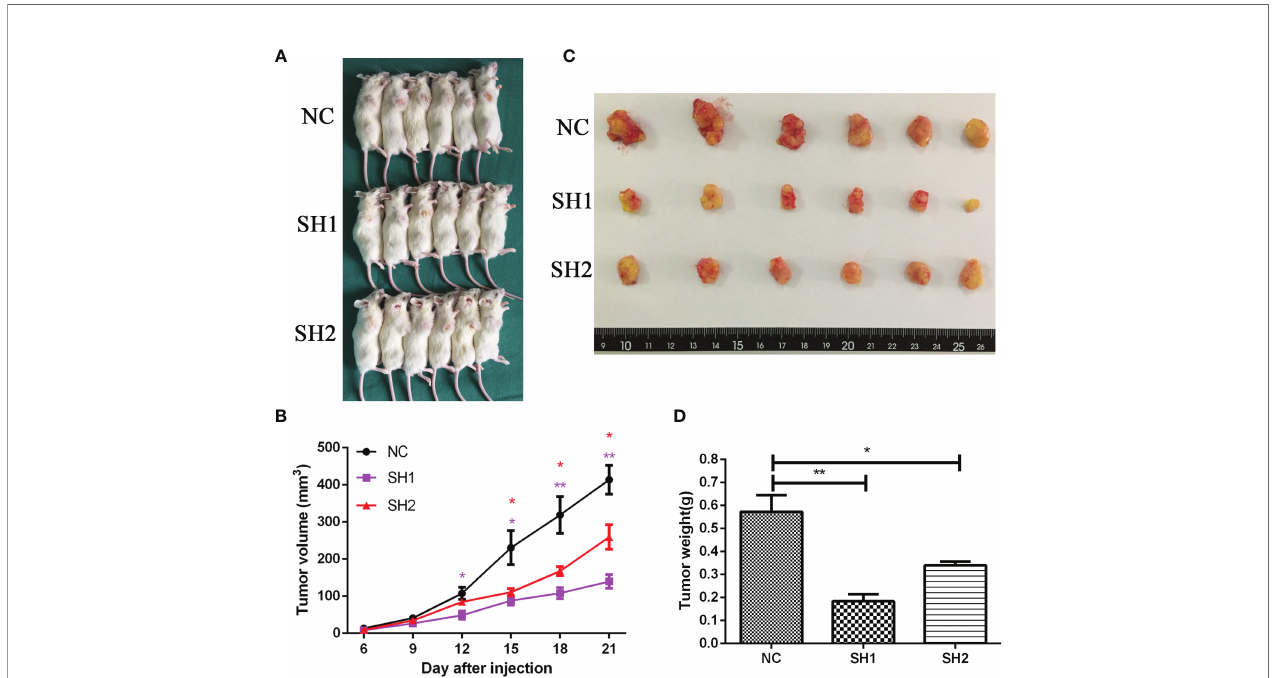
FIGURE 4 | DIAPH1 promotes the growth of AMC-HN-8 LSCC-derived tumors in NOD/SCID mice. (A) The transplanted tumor models were established by DIAPH1 knockdown (SH) cells and the negative control (NC) cells. (B) Tumor growth assay of three groups in vivo . (C) The tumor images 21 days after implantation. (D) Comparison of average weight of the tumor 21 days after implantation between three groups. ∗ p < 0 05, ∗∗ p < 0